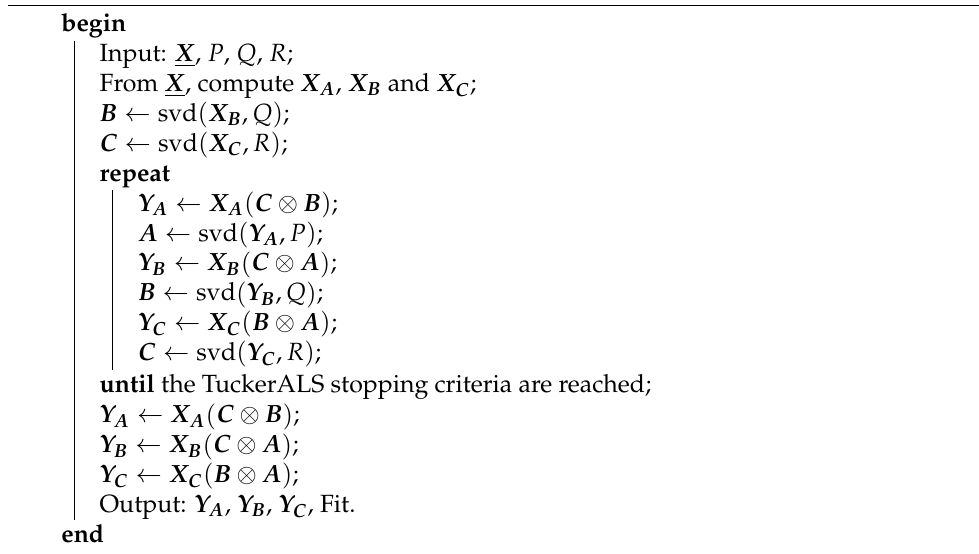
Algorithm 2: Adapted